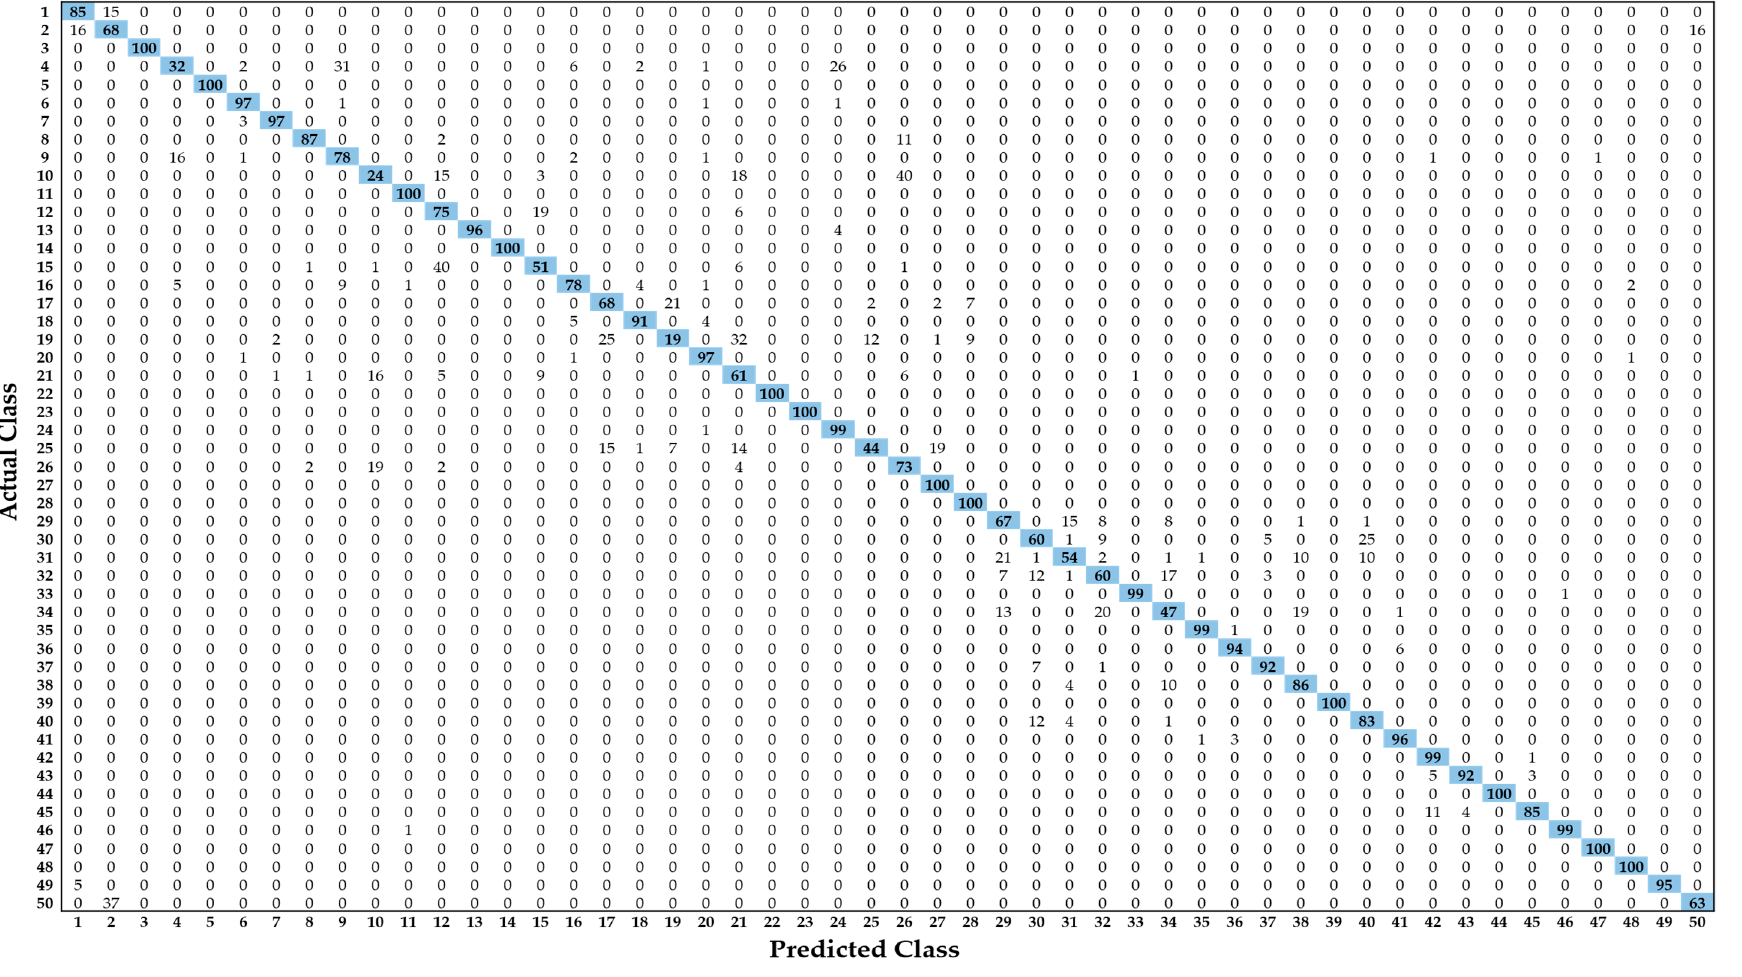
Figure 13. Confusion matrix of the proposed method. The entry in the 𝑖 -th row and 𝑗 -th column corresponds to the percentage of samples from class 𝑖 that were classified as class 𝑗 .